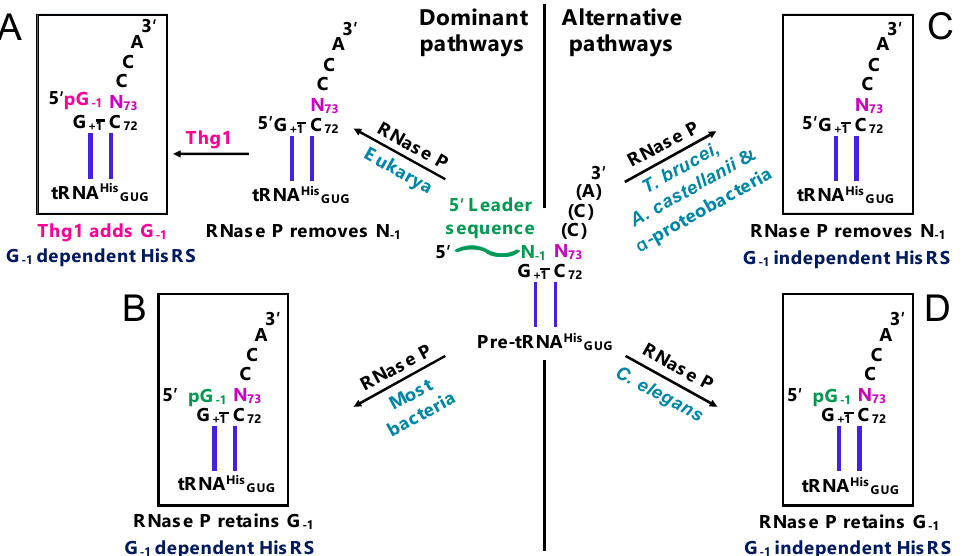
Figure 2. Different pathways to establish tRNA His identity. ( A ) tRNA His identity in many eukaryotes. RNase P removes N − 1 from pre-tRNA His during the removal of 5 (cid:48) leader sequence (shown in green). Then, tRNA His guanylyltransferase (Thg1) post-transcriptionally adds G − 1 (shown in pink). Histidyl-tRNA synthetase (HisRS) recognizes the Thg1-incorporated G -1 for the accurate histidylation of tRNA His in eukaryotes. ( B ) tRNA His identity in bacteria. G − 1 is encoded in tRNA His genes in most bacteria, and RNase P retains the genomically encoded G − 1 during the removal of the 5 (cid:48) leader sequence. HisRS recognizes the RNase P-retained G -1 for the accurate histidylation of tRNA His in bacteria. ( C ) tRNA His identity in several groups of α -proteobacteria, Trypanosoma brucei and Acanthamoeba castellanii . RNase P removes N − 1 from precursor tRNA His during the removal of the 5 (cid:48) leader sequence. An atypical HisRS in these organisms is capable of aminoacylating G − 1 -lacking tRNA His during histidylation. ( D ) tRNA His identity in Caenorhabditis elegans (an atypical eukaryote). G − 1 is encoded in tRNA His genes, and RNase P retains the genomically encoded G − 1 , which is similar to bacteria. HisRS in C. elegans is capable of aminoacylating both G − 1 -containing and G − 1 -lacking tRNA His